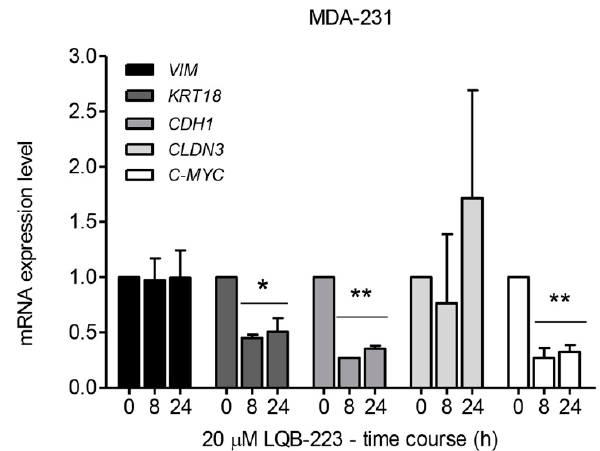
Figure 5. E ff ect of LQB-223 on epithelial-mesenchymal transition markers expression. MDA-231 cells were treated with 20 µ M LQB-223 for 8 and 24 h. VIM, KRT18, CDH1, CLDN3 and C-MYC mRNA levels were measured using qPCR and the 2 − ∆∆ C T method was used to calculate relative expression. The cells incubated with 20 µ M LQB-223 for 8 and 24 h were compared with the cells without LQB-223 (0 h). ACTB was used as the endogenous control. Mean and standard deviation from three independent experiments are shown. One-way ANOVA followed by Bonferroni post-test (* p < 0.05; ** p < 0.01).